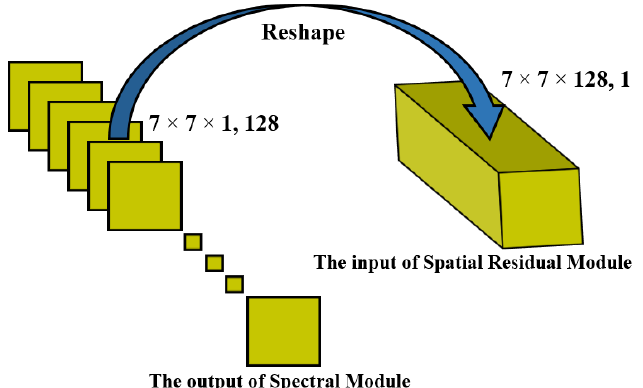
Figure 4. Overview of deformable